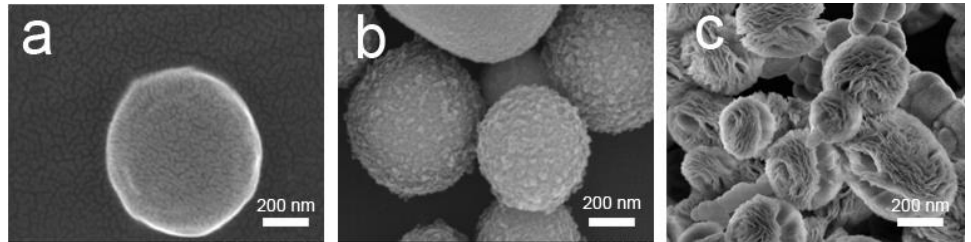
Figure 4. SEM images of CeO 2 samples prepared at 270 ◦ C for different reaction times: ( a ) 6 h; ( b ) 12 h; and ( c ) 24